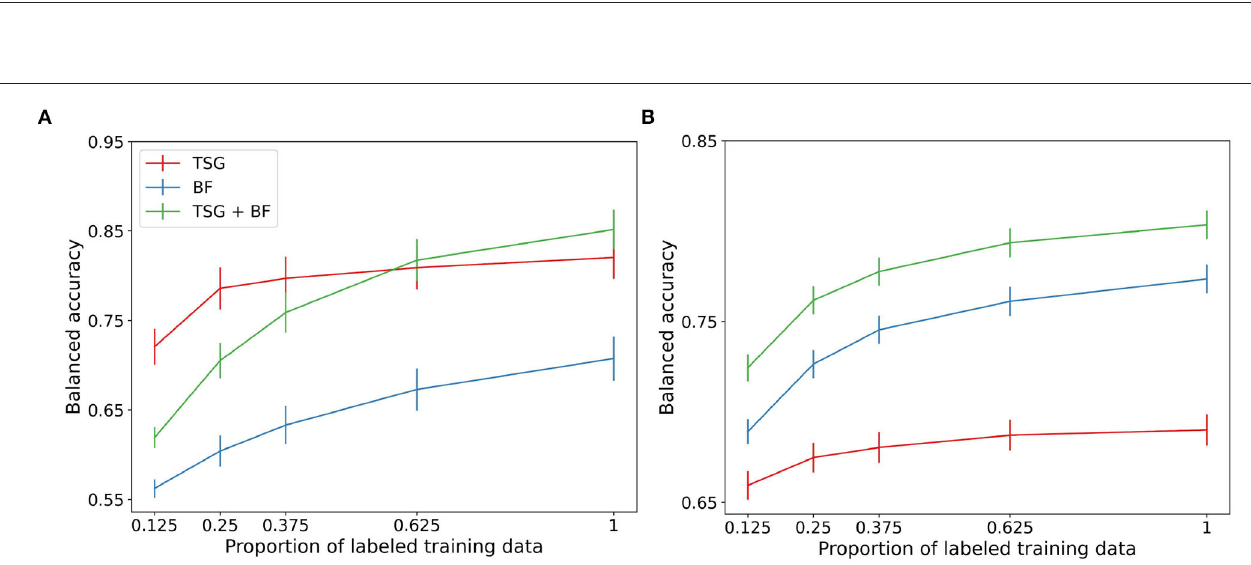
Frontiers in Human Neuroscience |